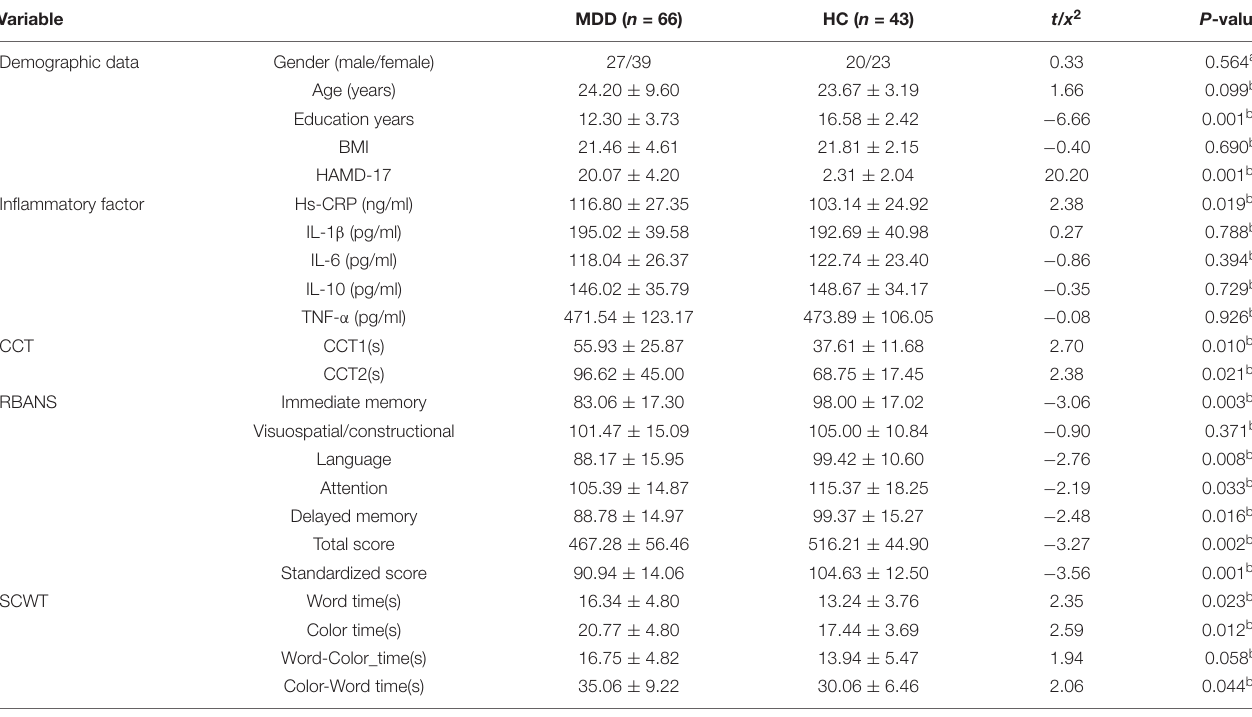
TABLE 1 | Clinical characteristics and inflammatory parameters. Variable